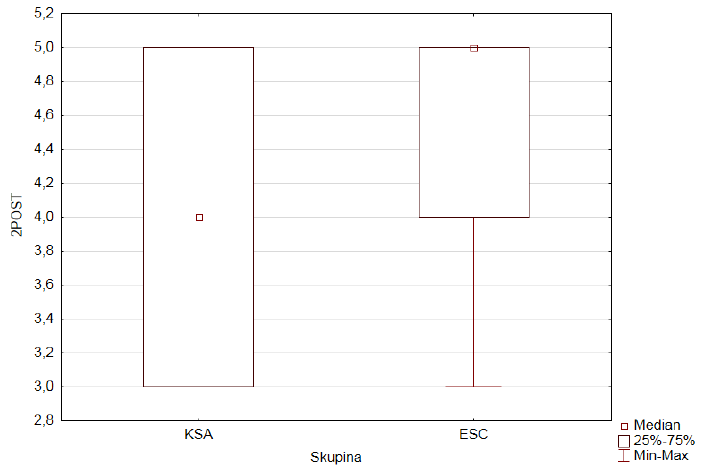
Figure 7. The box graph of the second item of the pretest - 2PRE.